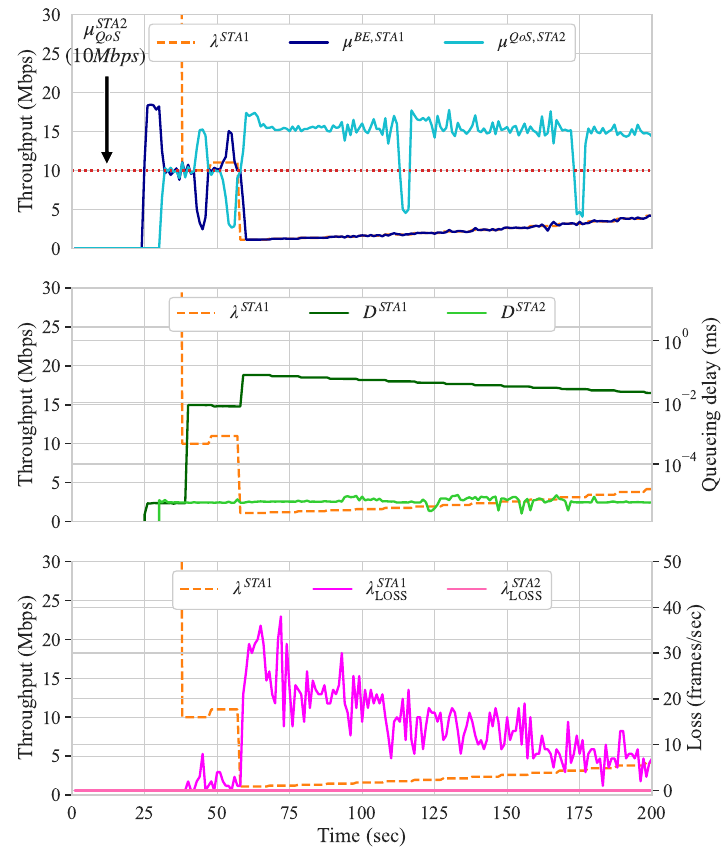
Figure 7. Scenario